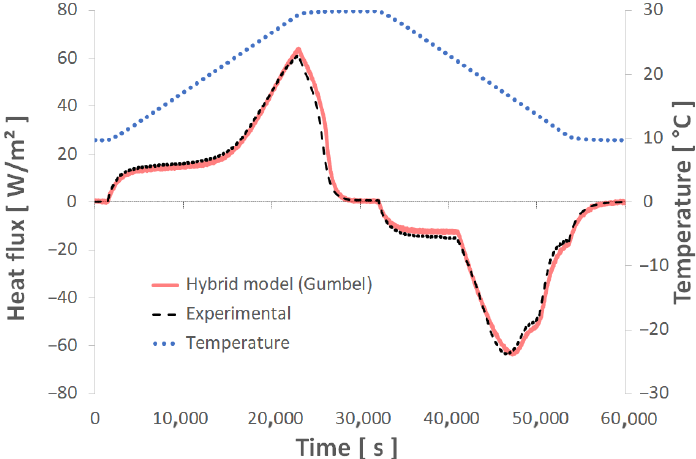
Figure 15. Evolution of the flux exchanged between the plate and the sample (6-h ramp).